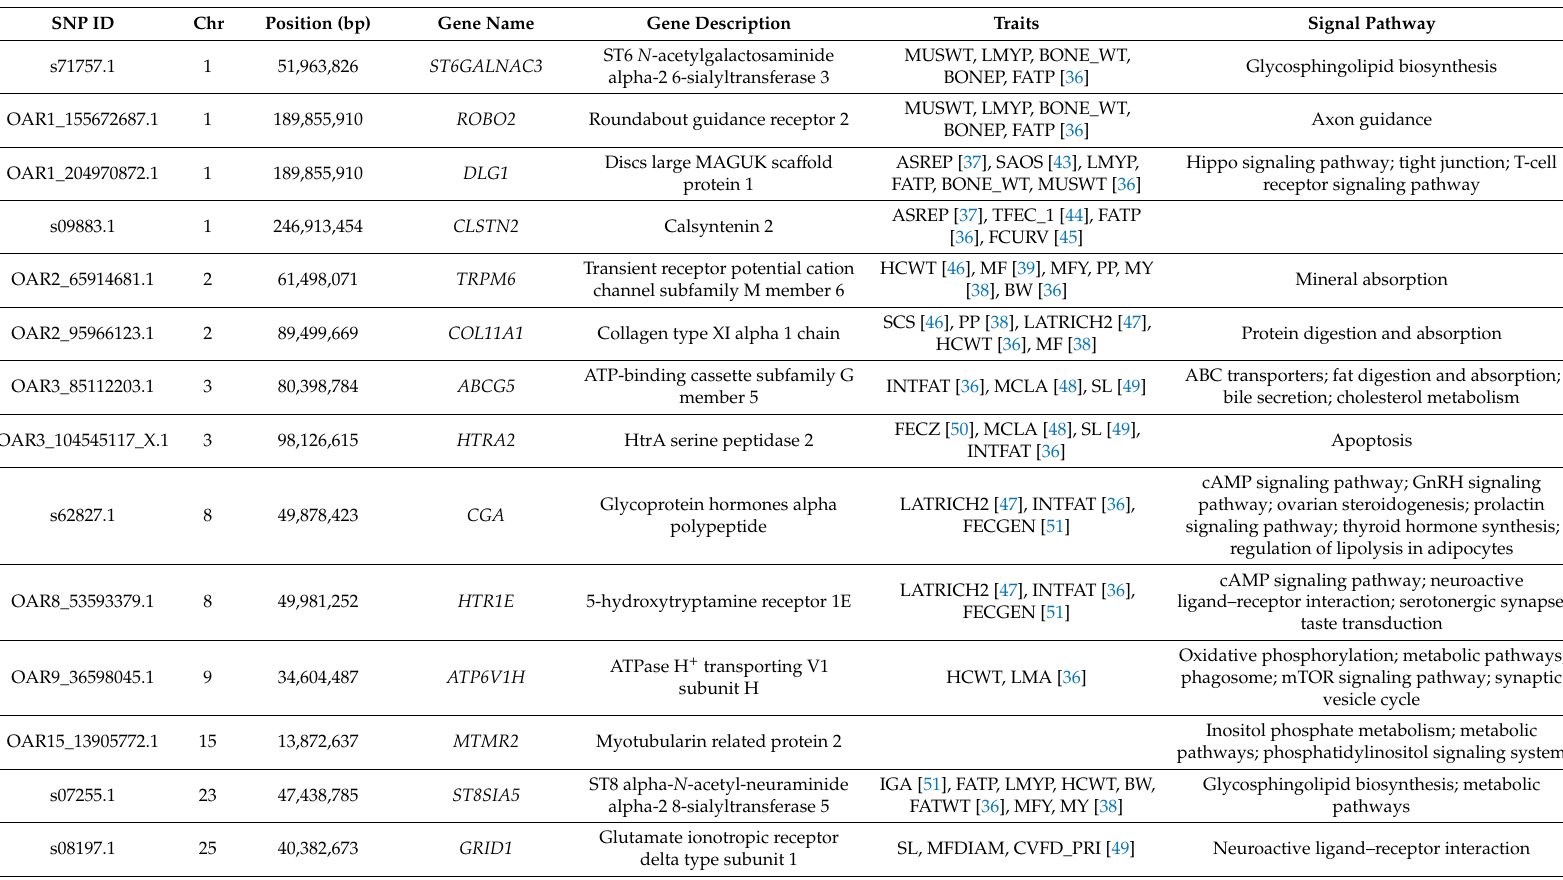
Table 1. SNPs identified by chromosome genome-wide association, traits, and biological pathway association with